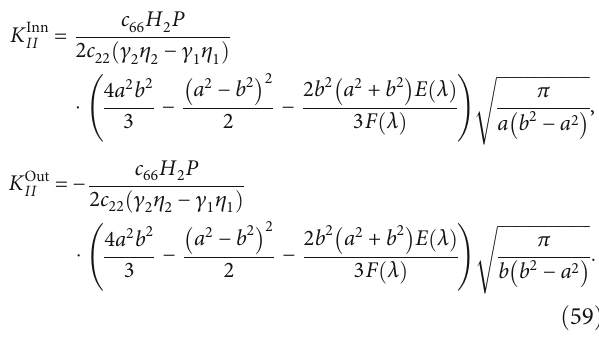
/ Q 1 c 1 versus x